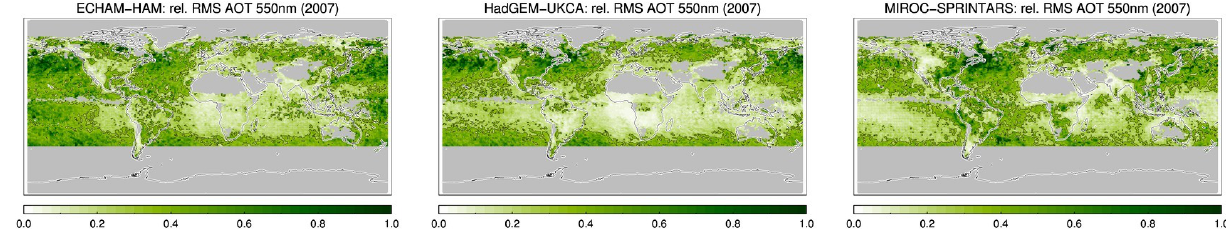
Figure 14. Ratio of the RMS (root mean squared) temporal sampling daily error to RMS model daily error, i.c. MODIS-NRL Aqua. The daily errors were defined according to UTC. The thin black contour represents a ratio of 0.3.